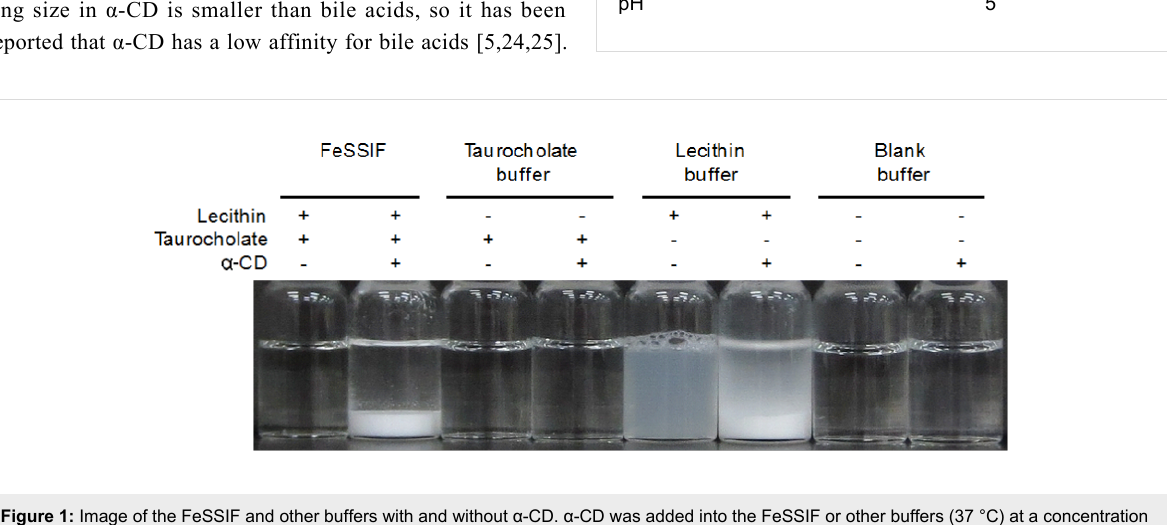
Figure 1: Image of the FeSSIF and other buffers with and without α -CD. α -CD was added into the FeSSIF or other buffers (37 °C) at a concentration of 5 w/v%. The taurocholate buffer was prepared using the same method as for FeSSIF preparation but without lecithin. The lecithin buffer was prepared using the same method as for the FeSSIF preparation but without sodium taurocholate. The blank buffer was prepared using the same method as FeSSIF preparation but both lecithin and sodium taurocholate were omitted.